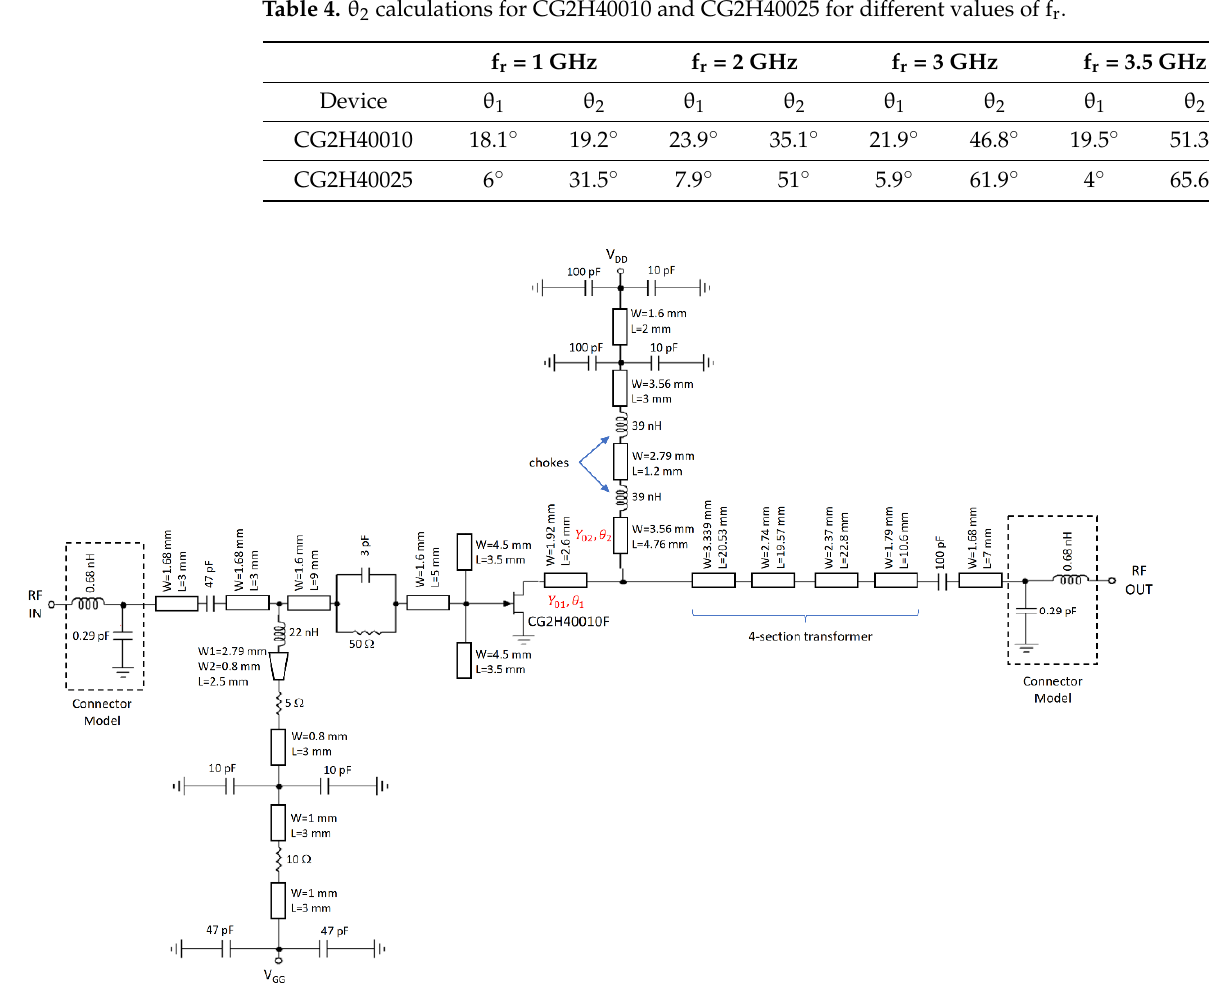
Figure 4. Schematic of the designed